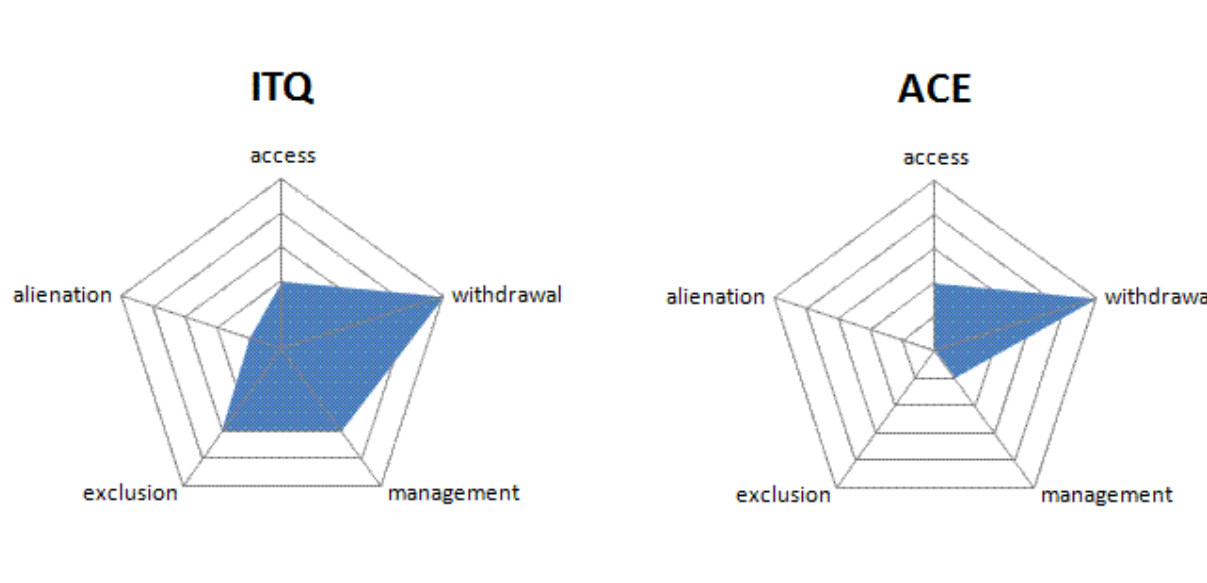
Fig. 3. Comparison of property rights bundles for commercial fishing: individual transferable quotas (ITQs) and annual catch entitlement